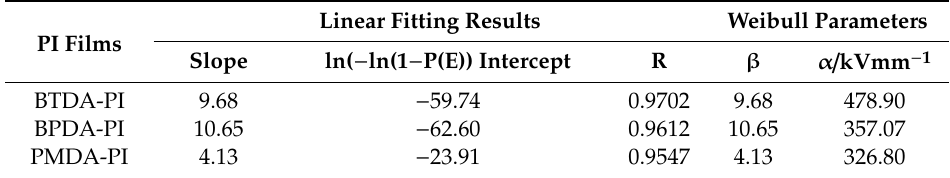
Table 1. Linear fitting results and Weibull parameters of PI films.